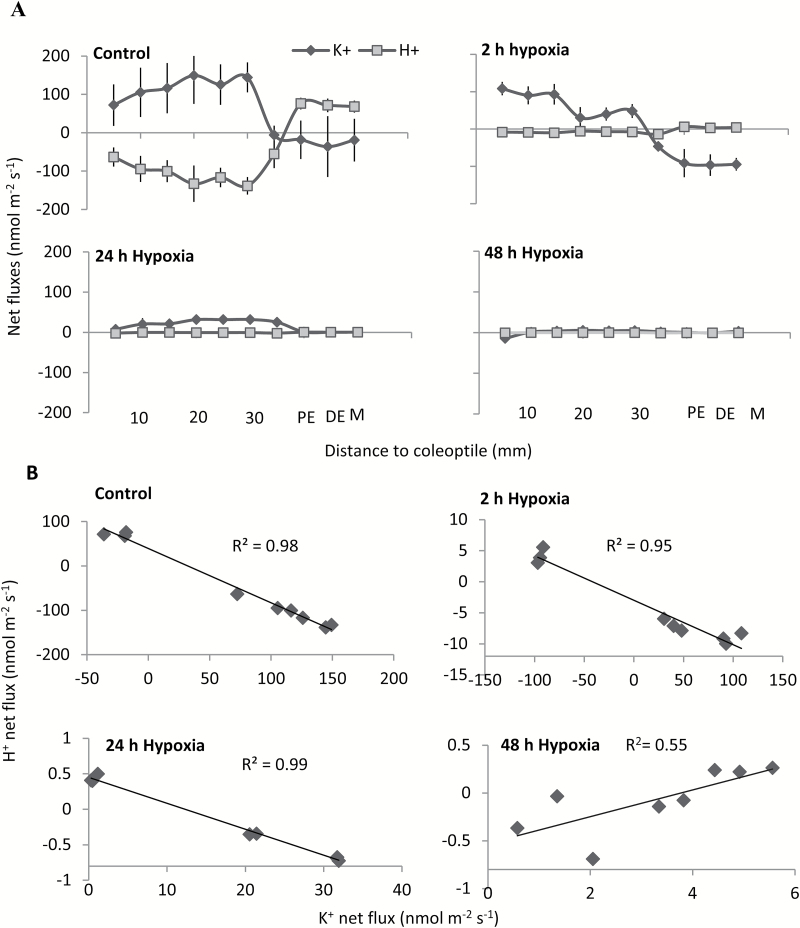
Net K+ and H+ flux response to hypoxia (N2-bubbled 0.2% agar) measured from excised roots of a waterlogging-sensitive cultivar (Gairdner). (A) Mean fluxes were measured along the barley root axis in control and after 2, 24, and 48 h of hypoxia treatment from different zones. P, pre-elongation; D, distal elongation; M, meristem. (B) Correlation between net K+ and H+ fluxes in control and hypoxia-treated roots measured at different time points. Data are the mean ±SE (n=6–8 individual plants).